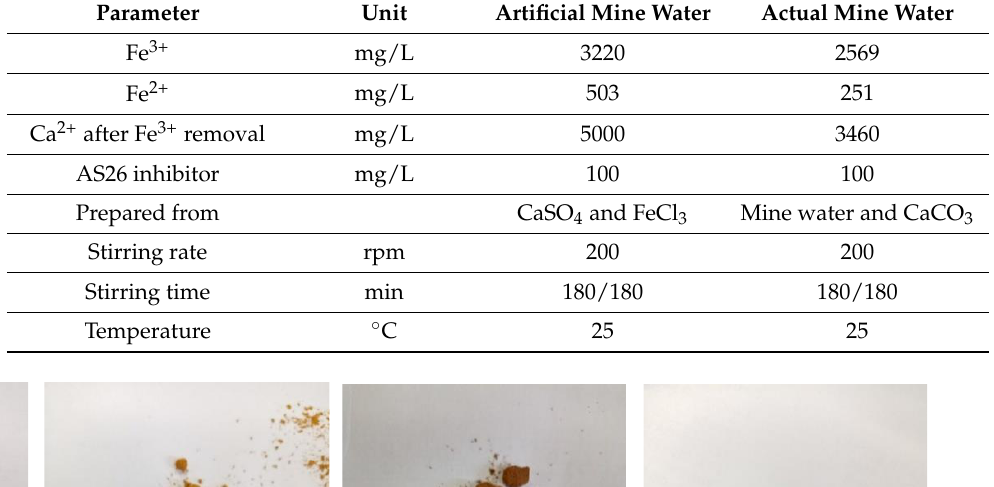
Figure 12. Effect of inhibitor concentration gypsum inhibition (Top Dam water, 15 g/L Acidity, 4 Table 2. Metals concentrations in Figure 3. g/L Fe 3+ , 22 g/L CaCO 3 , 0 g/L gypsum seed, 100, 200, 400 mg/L Inh A, 25 °C, stirring rate: 200 rpm;